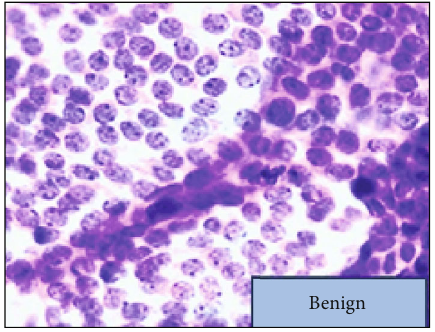
Figure 1: Image of a benign tumor cell.